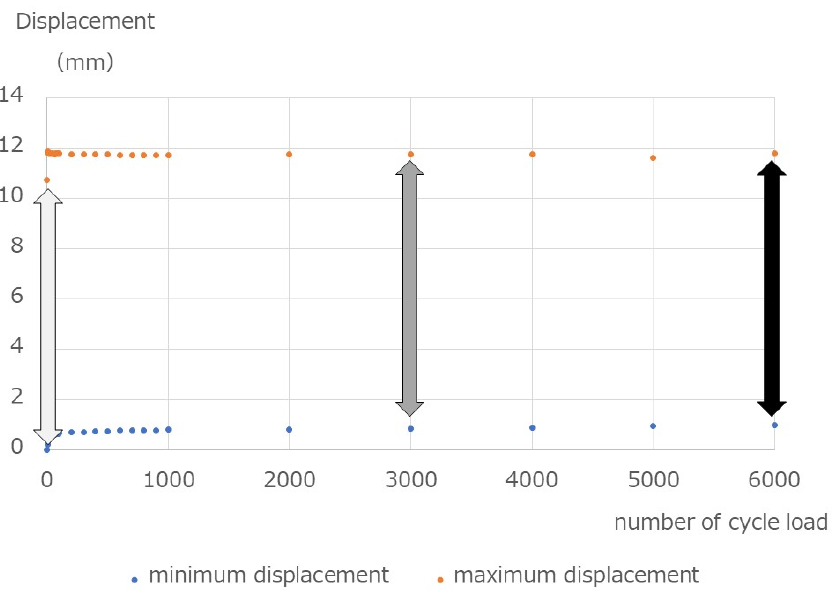
Figure 4. Displacements during the fatigue test. The specimen was repeatedly loaded with 40 N–400 N, and the minimum and maximum displacements observed in one cycle were recorded. The three arrows indicate that the difference was measured at three points: the first load (light gray arrow), midpoint in the fatigue test (dark gray arrow), and final load (black arrow). Moreover, the displacement after the test was